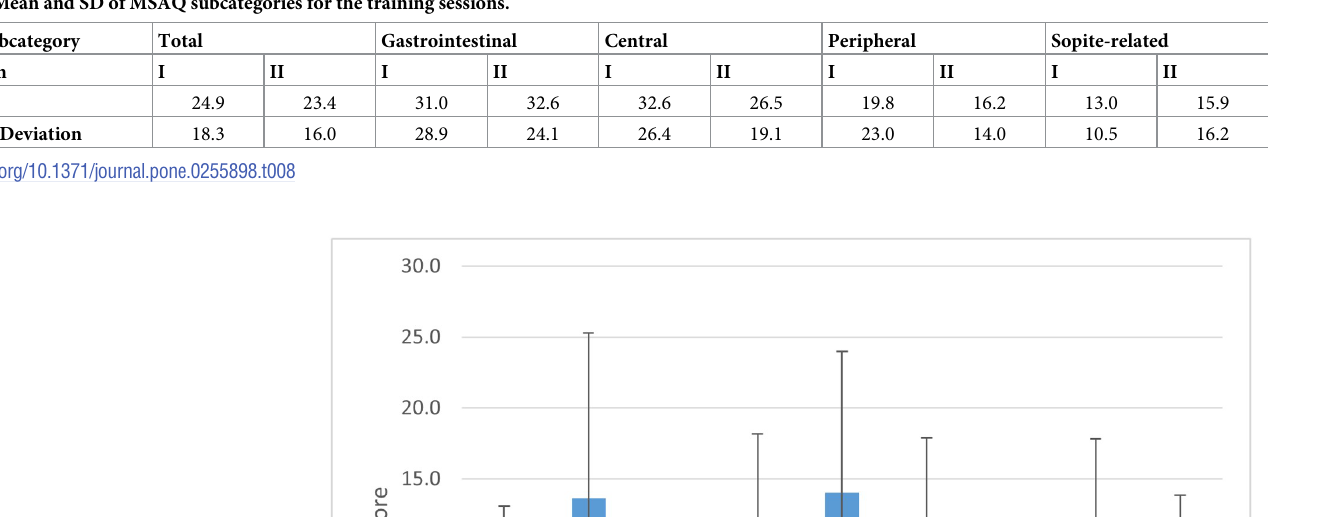
Analysis. 4: Comparing VR systems regarding the IPQ scores . We used a non-parametric method (Kruskal-Wallis) for analyzing the results of G and SP, and for the others (INV and ER) we used MANOVA which is more powerful (details on Tables 4 and 6). Kruskal-Wallis . The P-value of 0.19 and 0.23 for Kruskal-Wallis test for G and SP suggested that there is no meaningful difference between the VR systems with regard to G and SP. Also,